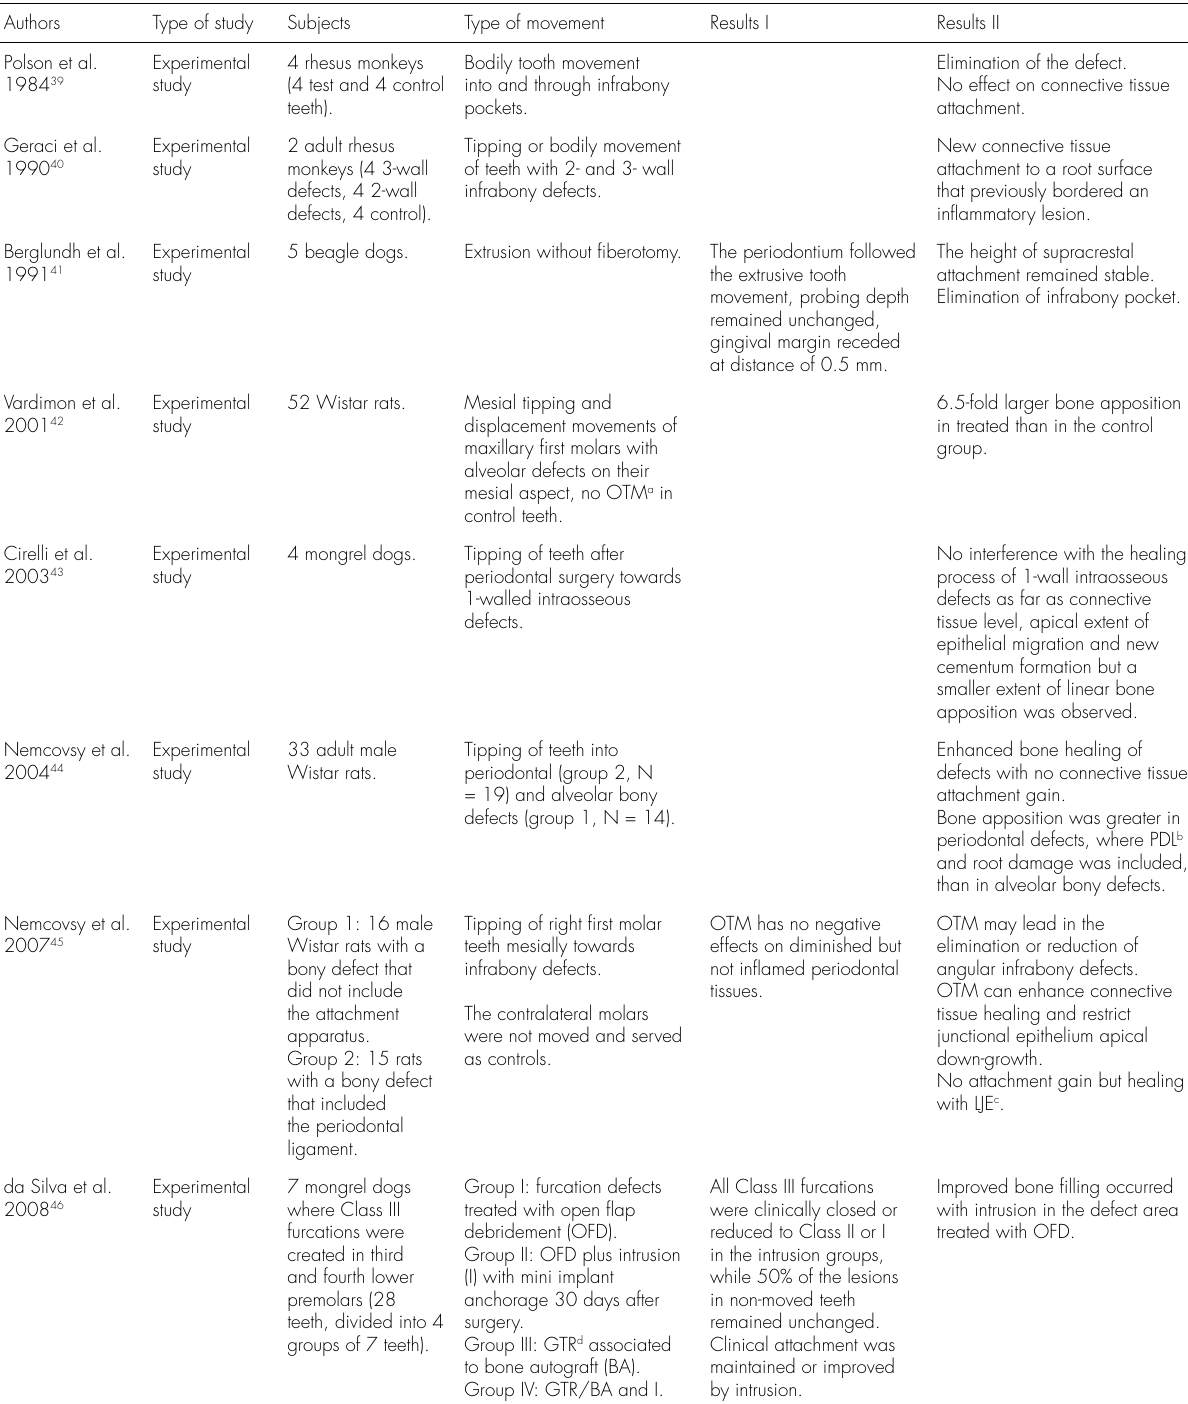
Table Ia. Orthodontic tooth movement in relation to angular bony defects treated with non-regenerative periodontal therapy: Experimental studies subgroup. Results I: The effects on clinical periodontal parameters. Results II: The effects on angular bony defect fill and connective tissue attachment